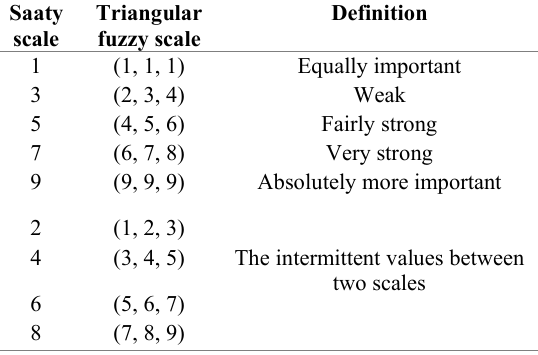
Table 1. The scales used to develop a pairwise comparison matrix in AHP and FAHP